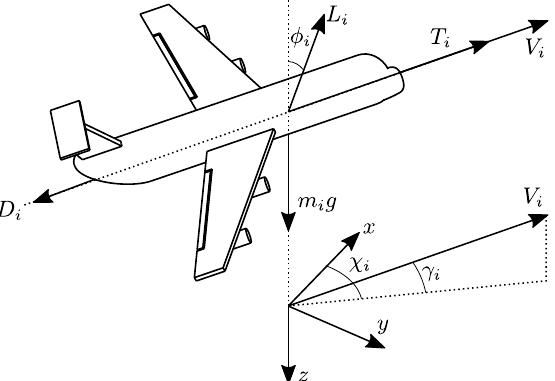
Figure 1. The i -th Unmanned Aerial Vehicle (UAV), its force and velocity vectors, and attitude